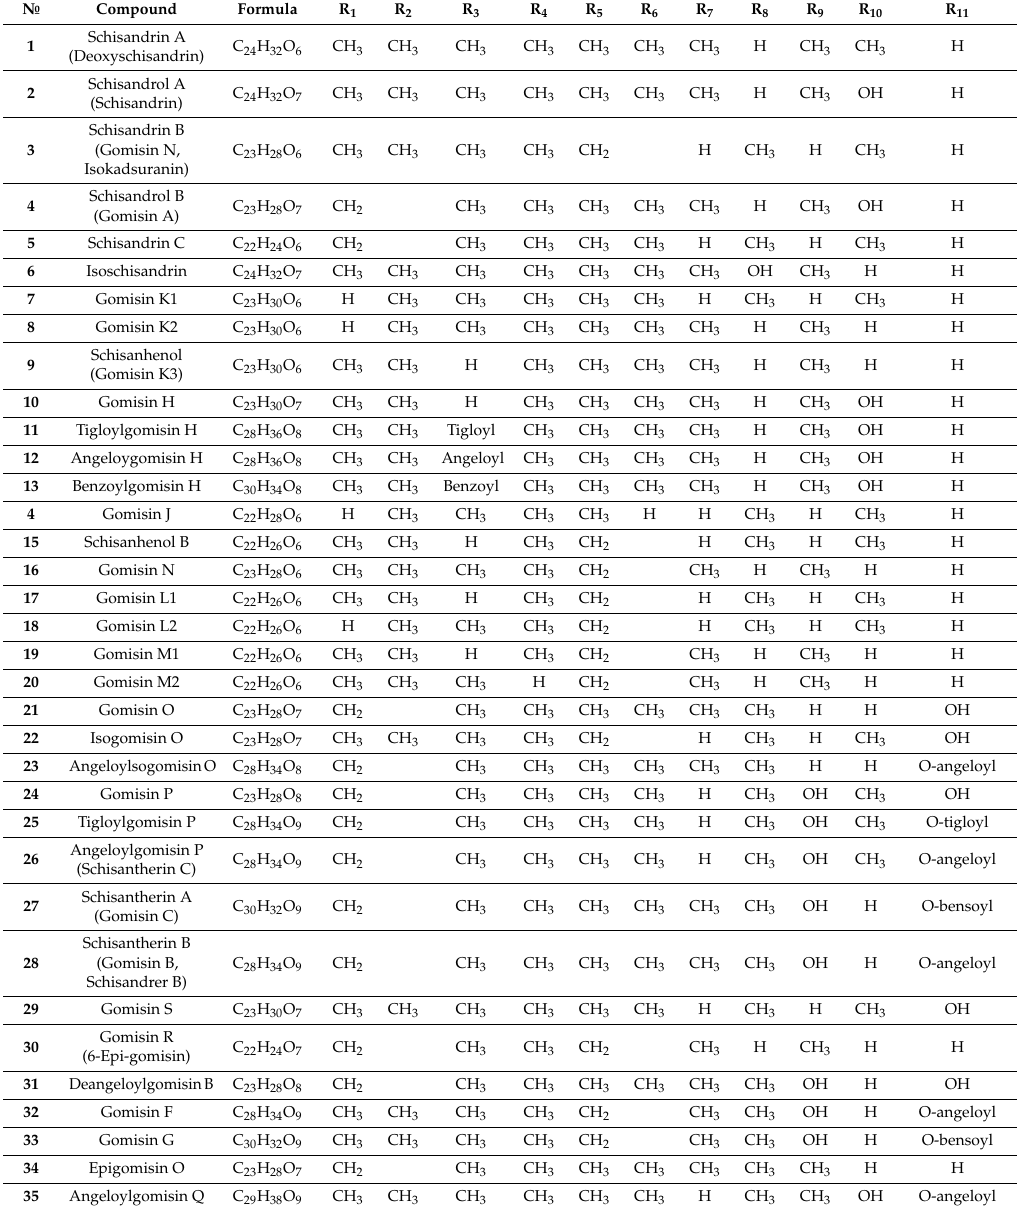
Table 1. Chemical structures of S. chinensis lignans, according to the authors